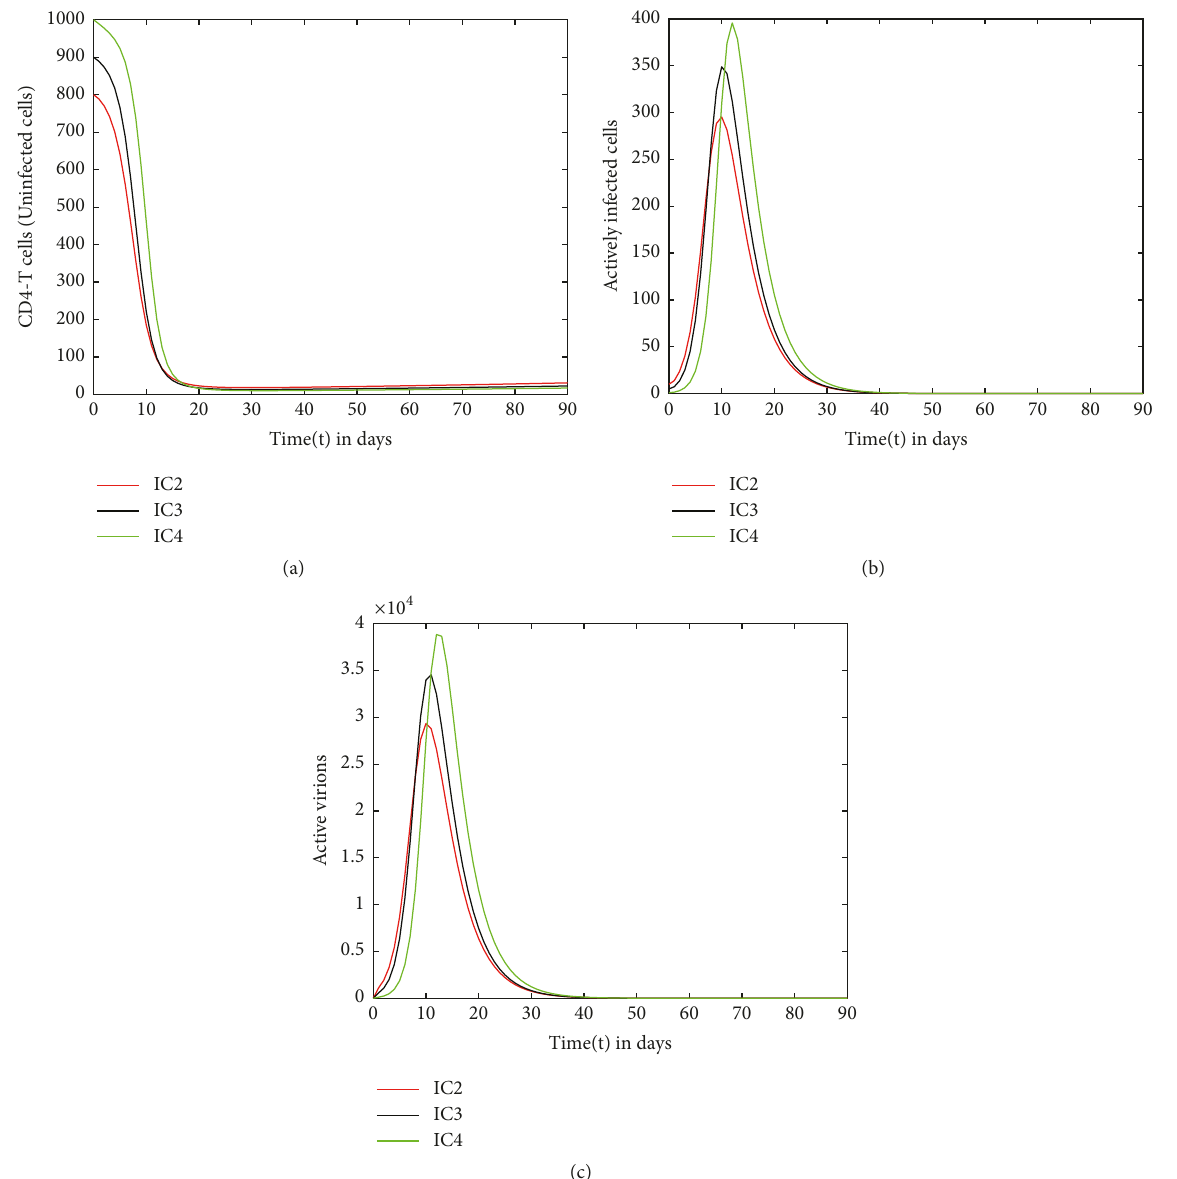
Figure 3: (a)-(c) The graph trajectory of 𝑇(𝑡) , 𝑇 ⋆ (𝑡) , and 𝑉(𝑡) for 𝜌 = 0.5 and 𝜗 = 0.5 with the initial conditions IC2-IC4. 𝑅 0 = 2.525 > 1 and 𝐸𝐸 = (198.02,4.98, 498.31) is